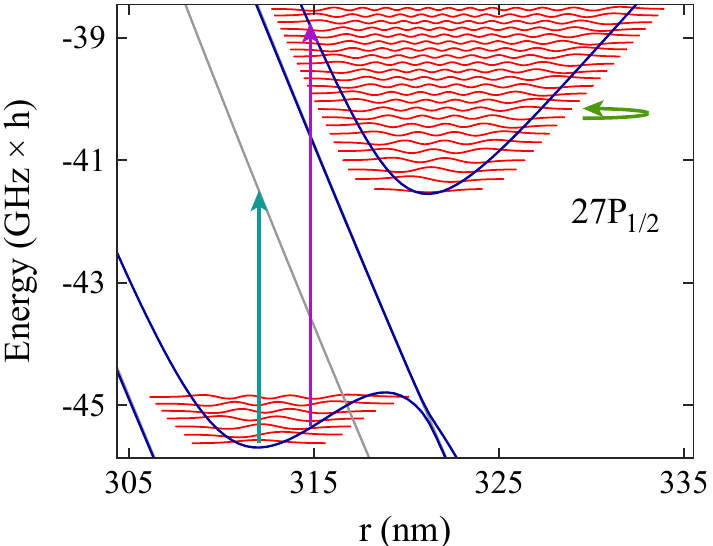
Figure 5. Examples for coupling of molecular levels. Shown are the potential energy curves in the region around the two outermost molecular potential wells associated with the 27 P 1/2 state of Rb. Blue (gray) solid lines indicate levels with | m J | = 1/2 ( | m J | = 3/2). Here, the reference for zero energy is the term energy of the 27 P 3/2 state at zero electric field ( r → ∞ ). The red solid lines correspond to wave functions of vibrational levels with l (cid:48) = 0. Their amplitudes are scaled for better visibility and are given in arbitrary units. The green arrow illustrates a transition between two neighboring vibrational states within the same potential well, which can be driven by a radio- frequency field. The purple vertical arrow represents a microwave transition between two vibrational states in different potential wells. The cyan vertical arrow indicates a transition from a bound state towards a repulsive potential energy